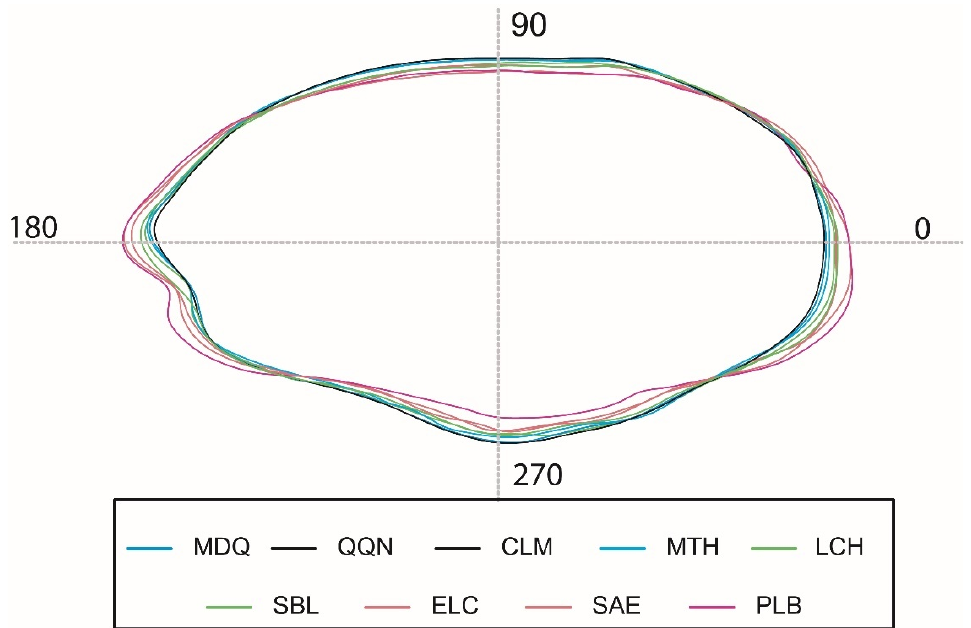
Figure 3. Mean shape of otolith shapes of silverside from nine localities. MDQ: Mar del Plata; QQN: Quequén; CLM: Claromecó; MTH: Monte Hermoso; LCH: La Chiquita; SBL: San Blas; ELC: El Cóndor; SAE: San Antonio Este; PLB: Puerto Lobos.